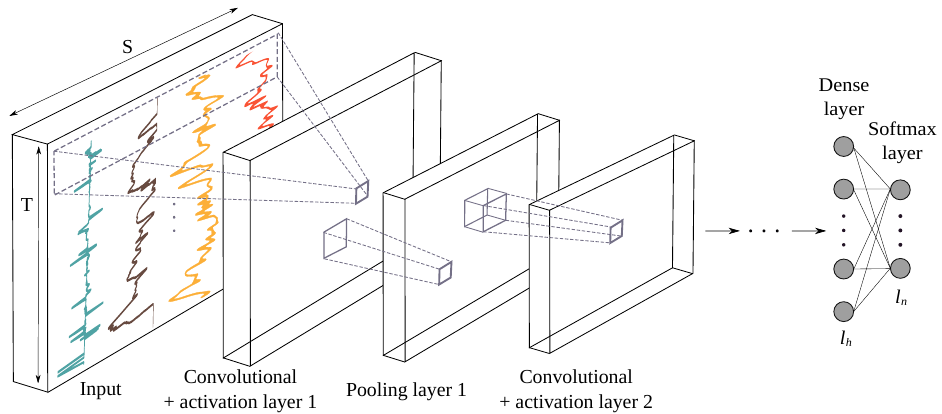
Figure 4. Architecture of a CNN model for accident detection. The designations n , h and S are the number of classes, layers and sensor channels, respectively. Convolutional layers apply convolution products on all convolution maps of the previous layer. Pooling layers then downsample the convolutional output and pass it to the next convolutional